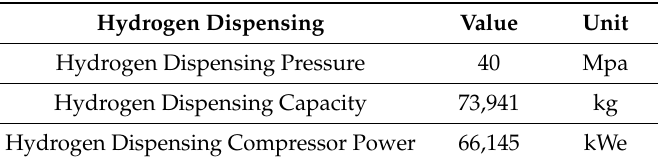
Table A5. Hydrogen Dispensing Main Data